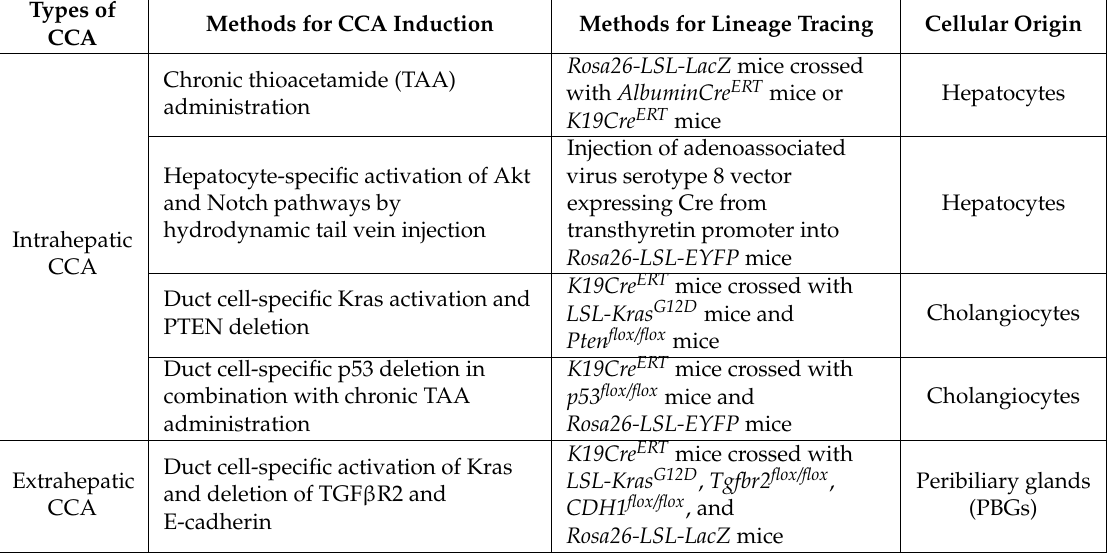
Table 1. Mouse models for tracing the cellular origin of cholangiocarcinoma